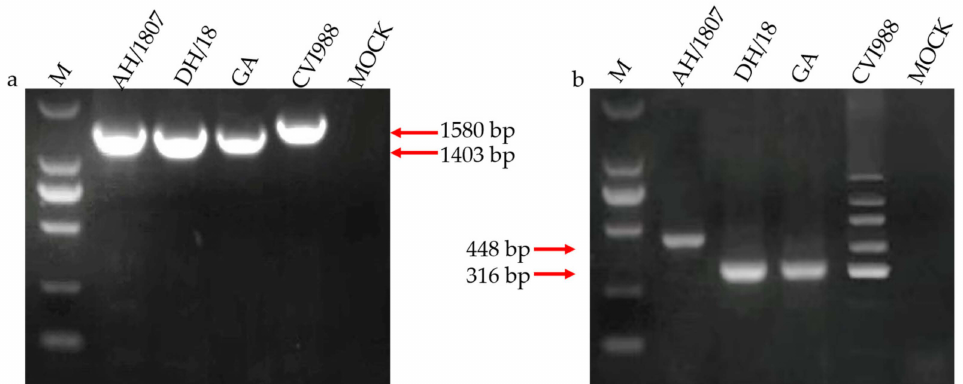
Figure 1. Detection of Marek’s disease virus (MDV) by polymerase chain reaction (PCR). DNA of MDV-infected duck embryo fibroblasts (DEFs) was used as the template for PCR amplification. ( a ) PCR amplification of the Marek’s EcoRI-Q ( meq ) gene of MDV. The PCR products of AH/1807 and DH/18 were 1,403 base pairs (bp) long; ( b ) PCR amplification of the 132-bp repeat (bpr) of MDV. The PCR product of AH/1807 132-bpr was 448 bp long with a copy number of 3, while the PCR product length for DH/18 was 316 bp with a copy number of 2. (M) DL 2000 DNA Marker; CVI988: Culture of CVI988 vaccine stain infected duck cells; GA: Culture of MDV strain GA-infected duck cells; MOCK: Culture of uninfected duck